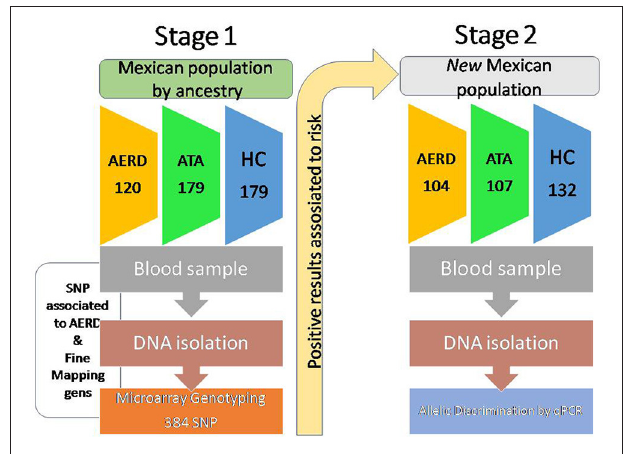
FIGURE 1 | Design of